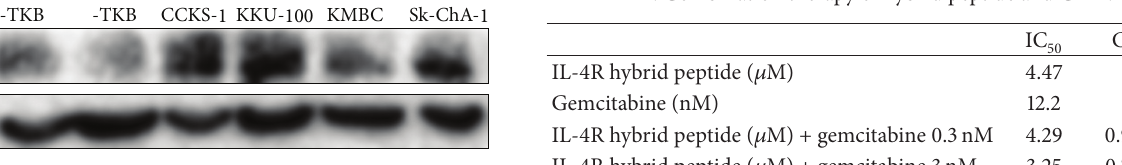
Table 2: Combination therapy of hybrid peptide and